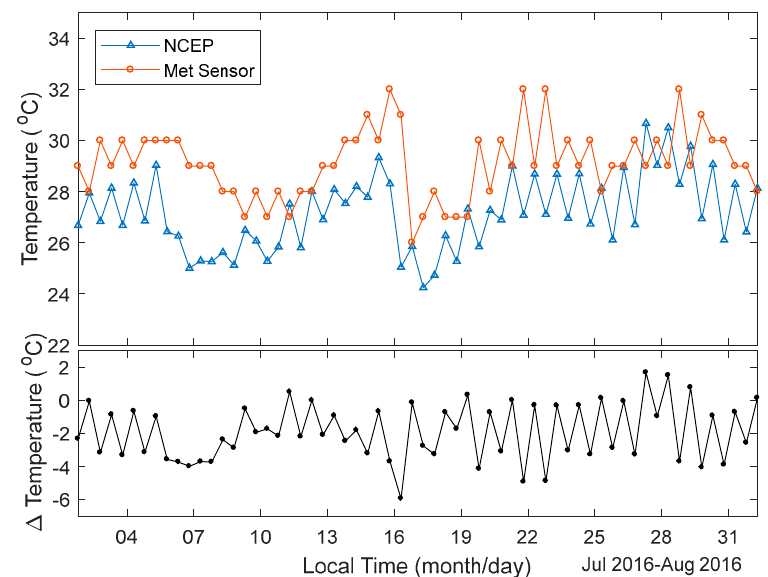
Figure 4. Temperatures at CORS Taiz station and HOJA radiosonde station in July ( top panel), and the temperature differences in July ( bottom panel).